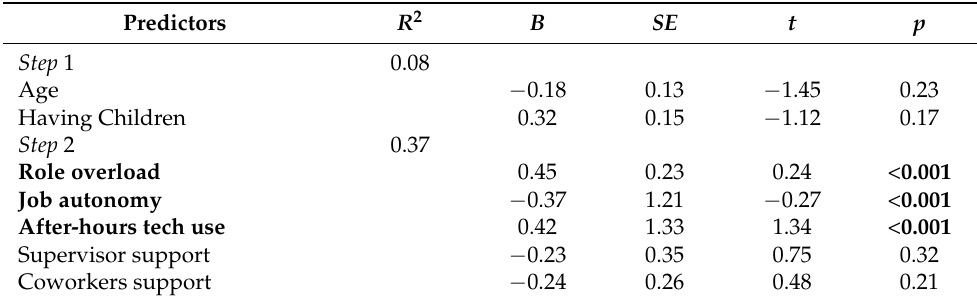
Table 2. Predictors of work–family